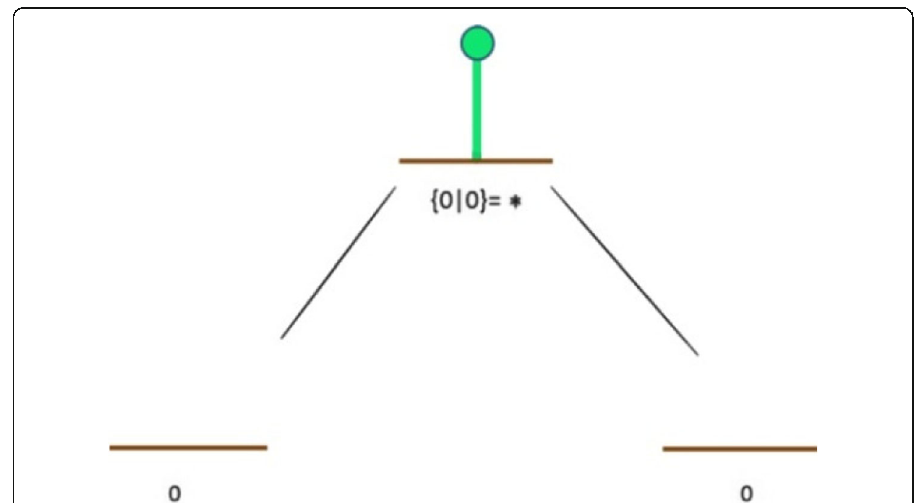
Fig. 6 Example of a ∗ game with a green